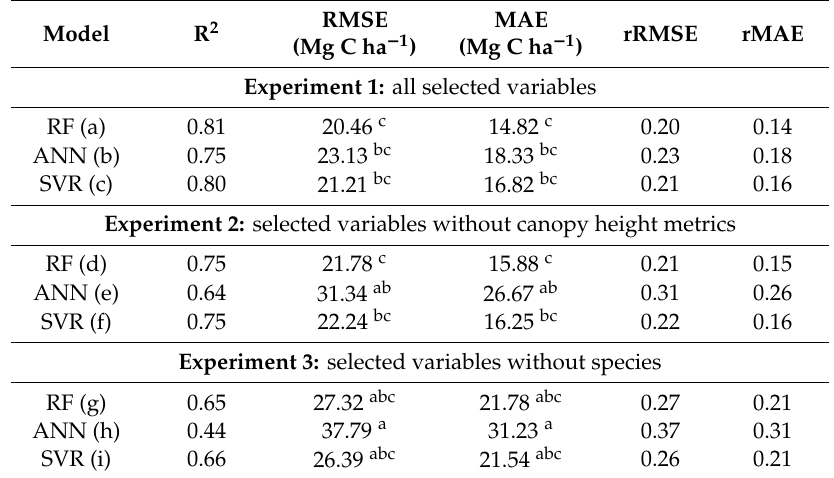
Table 4. Model performance for AGC estimation based on 10-fold cross validation. (RMSE: root